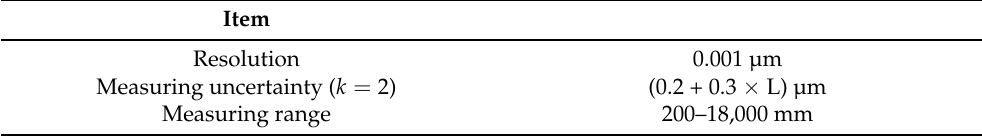
Table 2. LaserTRACER